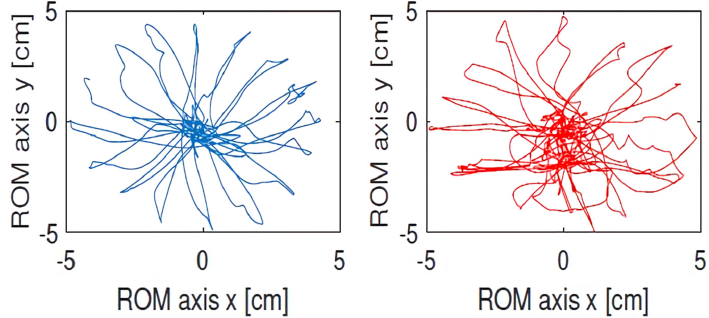
Figure 7. Example of a Healthy (blue) and SCI (red) participant range of motion (ROM) measured from the end-e ff ector of Novint Falcon device in the Collecting stars